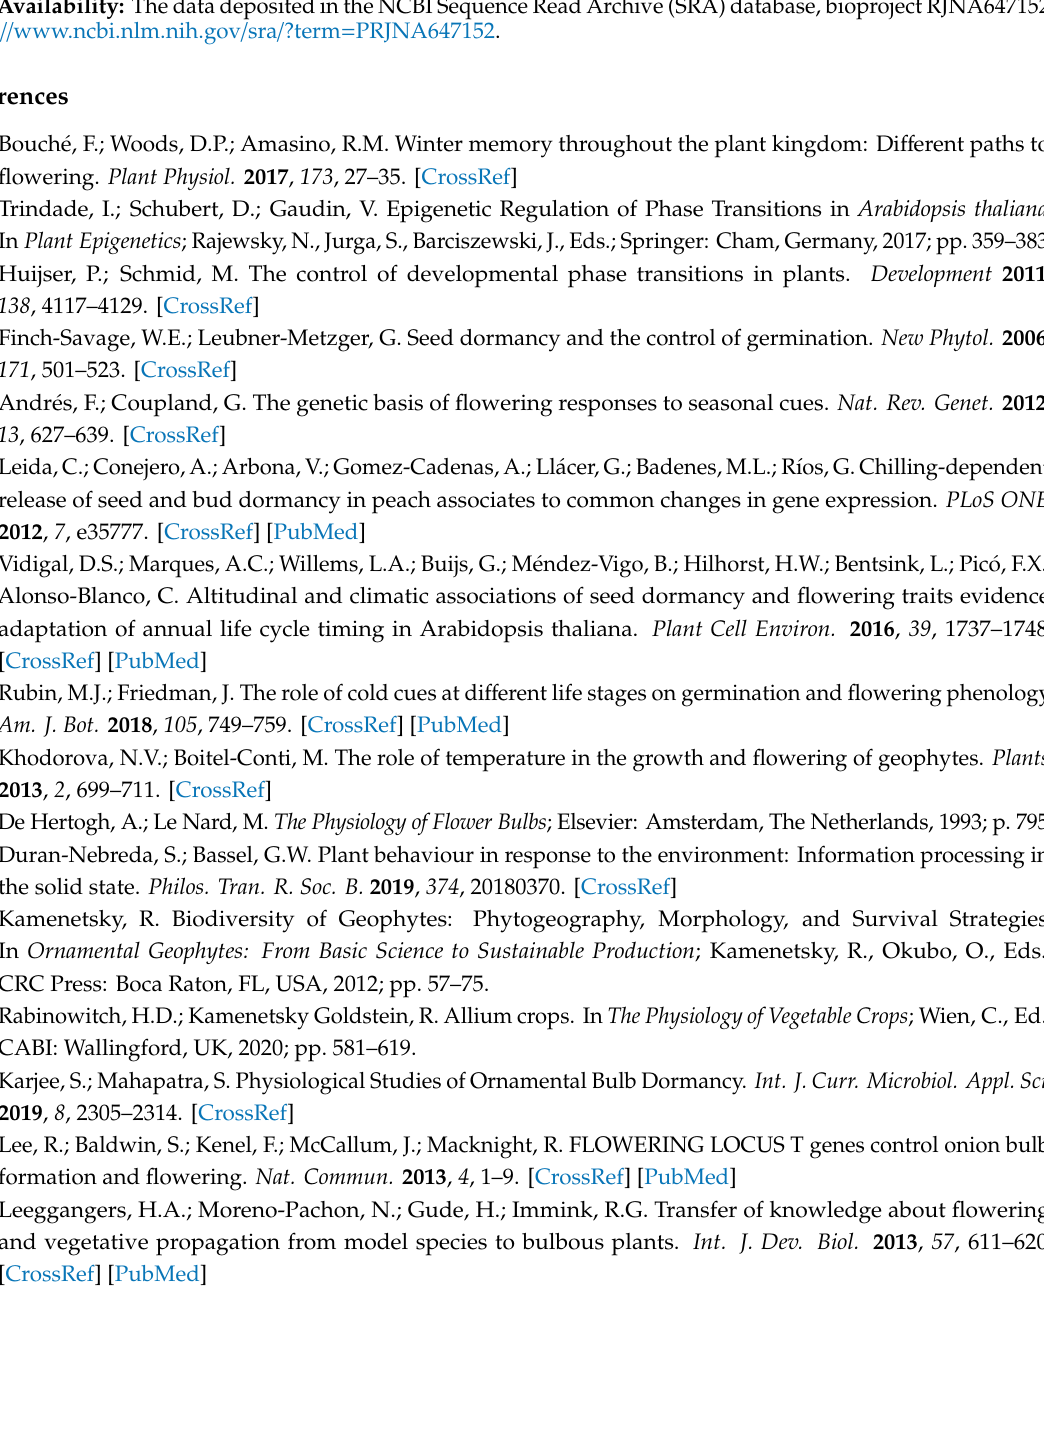
Figure S1: Daylength and average air temperatures (based on 8 measures / day) in Bet Dagan, Israel during growth season 2015–2016; Figure S2: Pathways of glycolysis and gluconeogenesis in imbibed and stratified garlic seeds as revealed by KEGG algorithm osa00010. Over-representation in stratified seeds is marked in red, over-representation in imbibed seeds is marked in blue; Table S1: List of 61 homologous genes associated with seed dormancy and germination, proliferation, glycolysis and glucose transport and meristem identity in seeds of Allium sativum . Short description according to UniProt database and literature